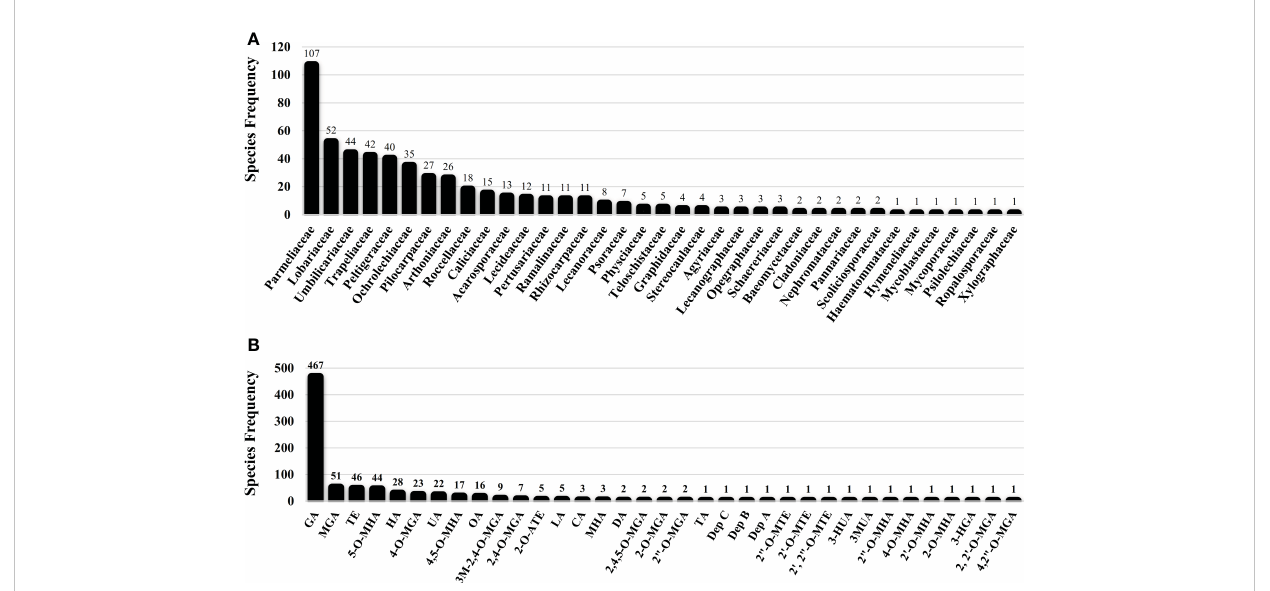
FIGURE 3 Lichen species frequency; (A) Family-based frequency of tridepside-producing lichen species reported in this study; (B) Frequency of tridepside- producing lichen species based on their detected tridepside; total number of tridepside-producing lichen species that we could fi nd in the literature was 526; (Tridepsides ’ abbreviations ! GA: Gyrophoric acid/MGA: Methylgyrophoric acid/TE: Tenuiorin/5-O-MHA: 5- O -methylhiascic acid/HA: Hiascic acid/ 4-O-MGA: 4- O -methylgyrophoric acid/UA: Umbilicaric acid/4,5-O-MHA: 4,5-di- O -methylhiascic acid/OA: Ovoic acid/3M-2,4-O-MGA: 3-methoxy-2,4- di- O -methylgyrophoric acid/2,4-O-MGA: 2,4-di- O -methylgyrophoric acid/2-O-ATE: 2- O -acetyltenuiorin/LA: Lasallic acid/CA: Crustinic acid/MHA: Methylhiascic acid/DA: Deliseic acid/2,4,5- O -MGA: 2,4,5-tri- O -methylhiascic acid/2-O-MGA: 2- O -methylgyrophoric acid/2 ” -O-MGA: 2 ” - O - methylgyrophoric acid/TA: Trivaric acid/Dep C: depsidellin C/Dep B: depsidellin B/Dep A: depsidellin A/2 ” -O-MTE: 2 ” - O -methyltenuiorin/2 ’ -O-MTE: 2 ’ - O -methyltenuiorin/2 ’ , 2 ” -O-MTE: 2 ’ ,2 ” -di- O -methyltenuiorin/3-HUA: 3-hydroxyumbilicaric acid/3MUA; 3-methoxyumbilicaric acid/2 ” -O-MHA: 2 ’’ - O - methylhiascic acid/4-O-MHA: 4- O -methylhiascic acid/2 ’ -O-MHA: 2 ’ - O -Methylhiascic acid/2-O-MHA: 2- O -methylhiascic acid/3-HGA: 3- hydroxygyrophoric acid/2, 2 ’ -O-MGA: 2,2 ’ -di- O -methylgyrophoric acid/4,2 ” -O-MGA: 4,2 ” -di- O -methylgyrophoric